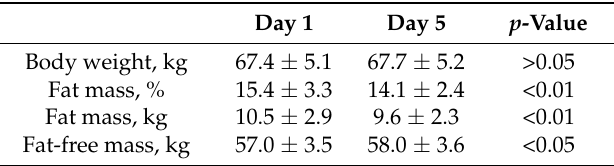
Table 2. Body weight and body composition